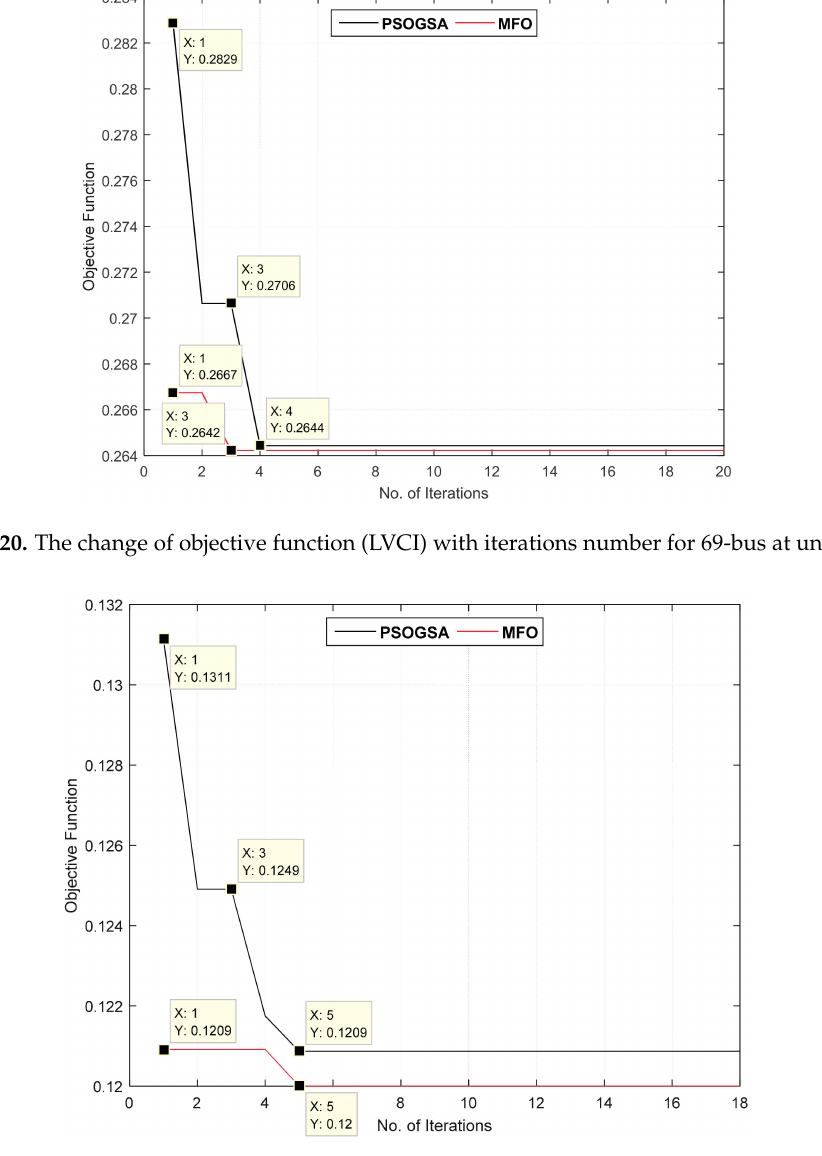
Figure 21. The change of objective function (LVCI) with iterations number for 69-bus at 0.866